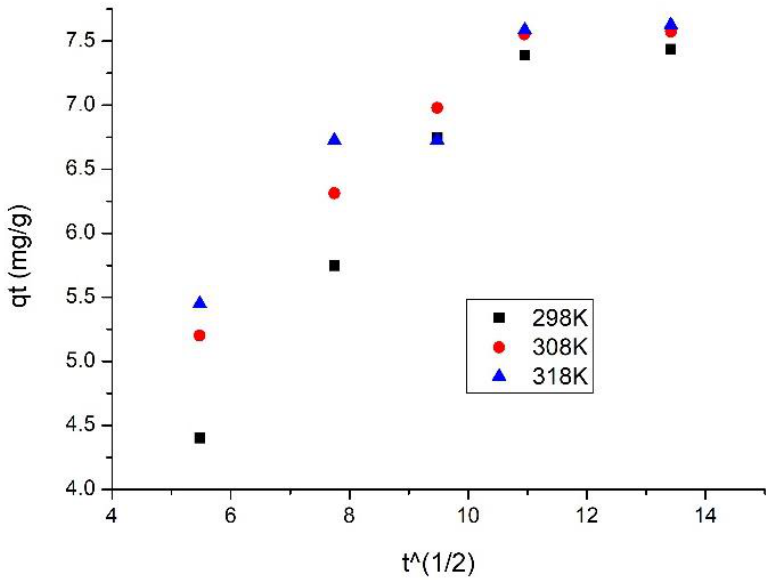
Figure 10. Intraparticle diffusion models for three different temperatures. Table 4. Specific parameters of intraparticle diffusion for SiO 2 Fe x O y